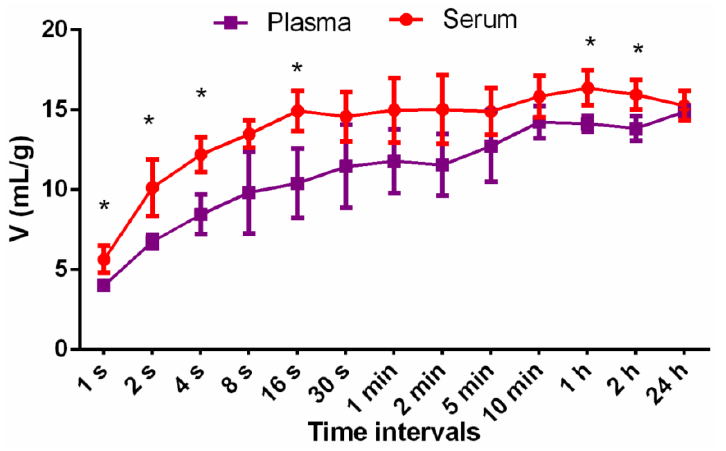
Figure 6. Exudate absorption capacity of the chitosan/agarose (CHN/A) biomaterial presented as a volume (mL) of serum/plasma absorbed by 1 g of the material (* statistically significant results compared to the plasma; p value < 0.05, unpaired t -test).